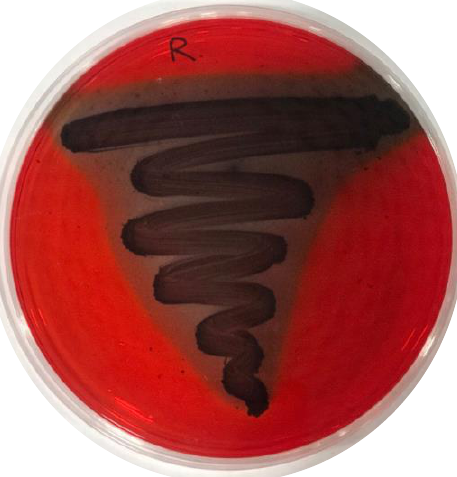
Figure 3 . Staphylococcus aureus biofilm formation (black colony) on congo red